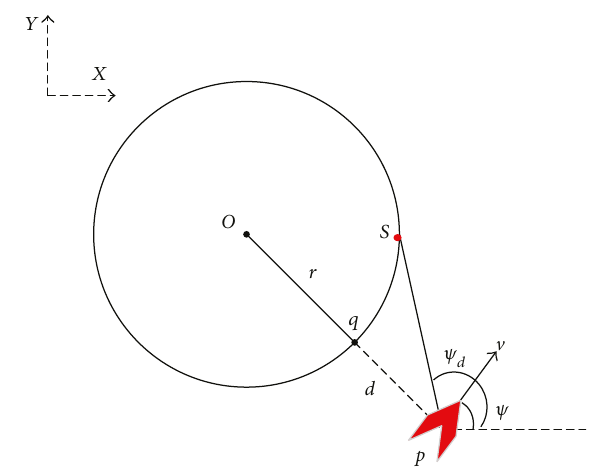
Figure 6: Loiter carrot-chasing